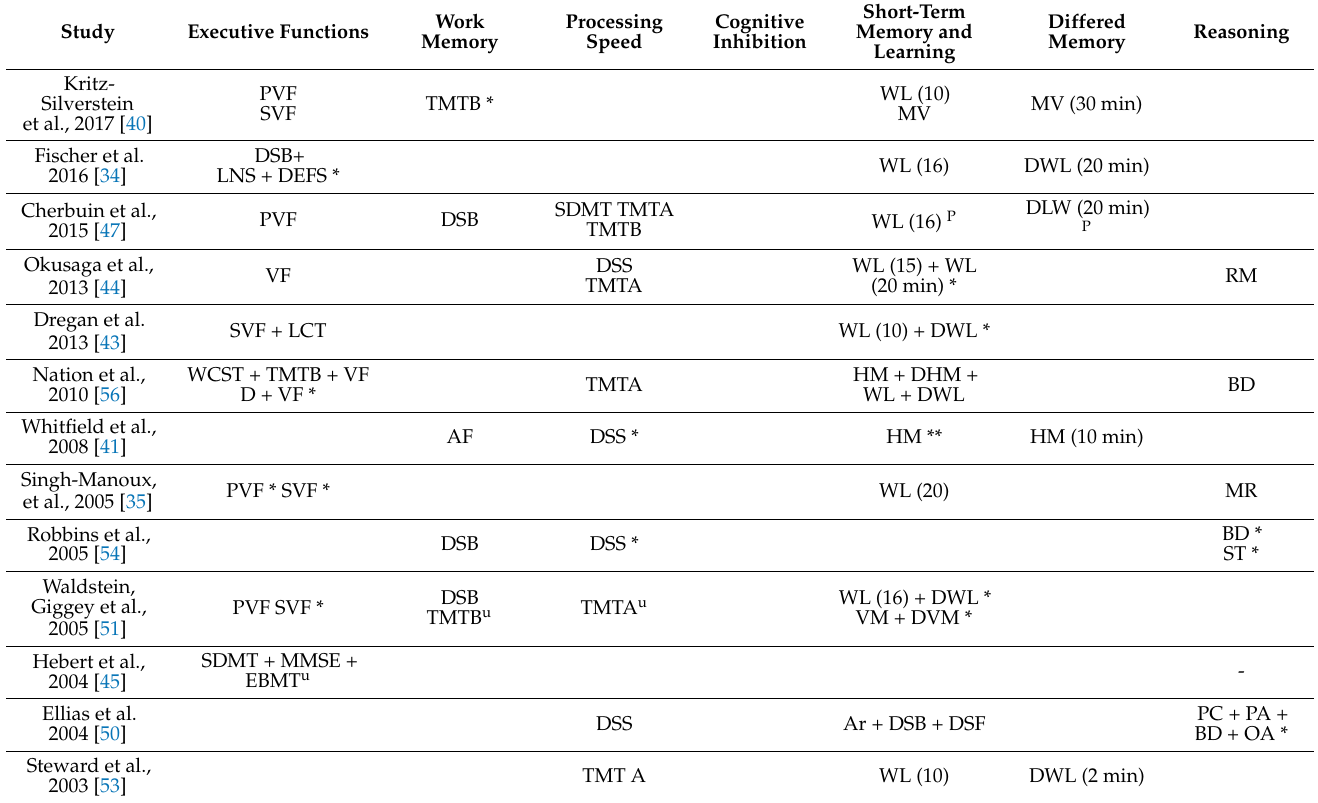
Table 2. Cognitive processes included in the studies of blood pressure and cognitive performance in older adults.